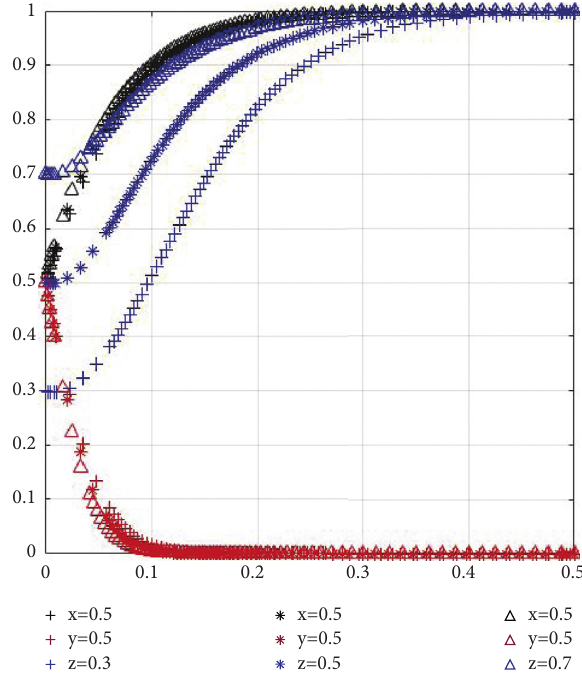
Figure 3: The evolution result of the change of We Media par- ticipation willingness y ( y � 0.3 ⟶ y � 0.5 ⟶ y � 0.7).